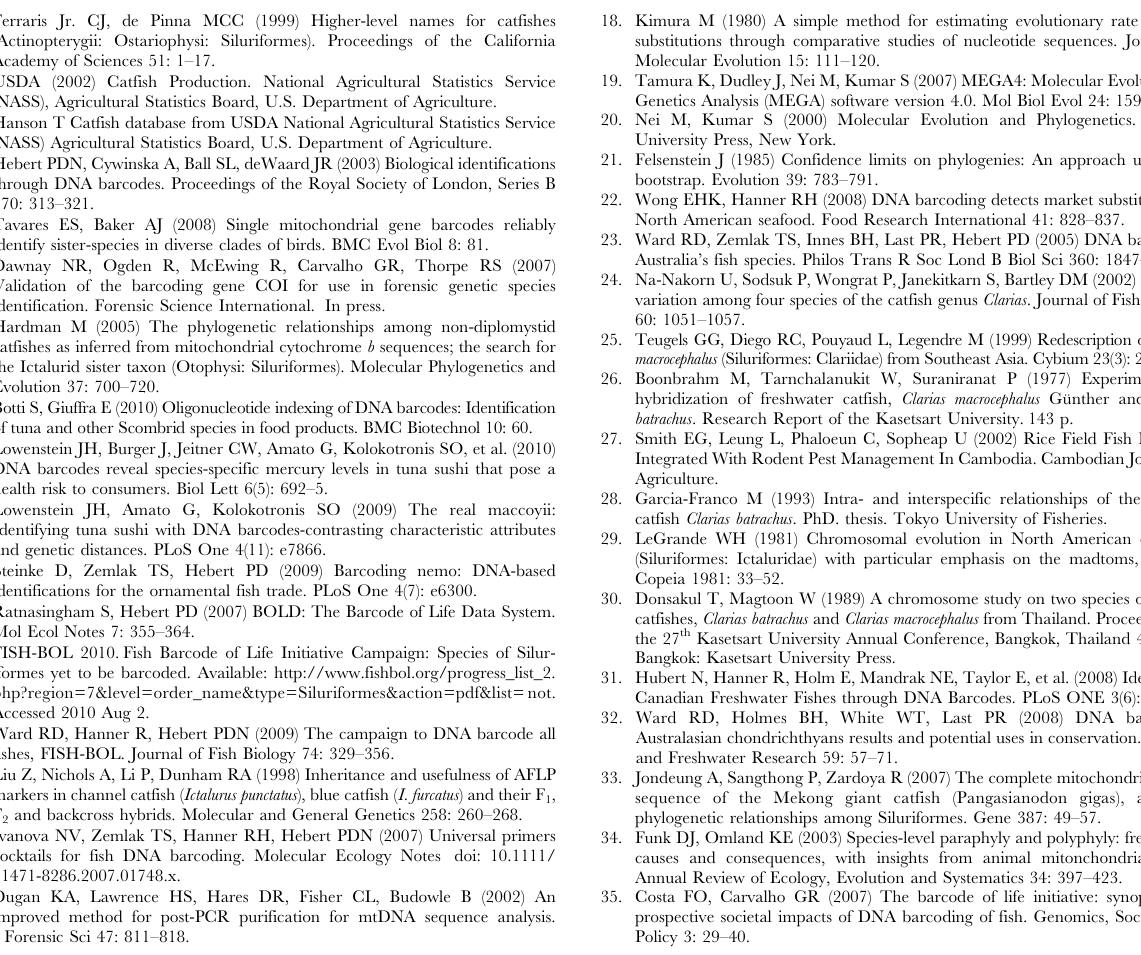
Table S1 Primers used for PCR amplification and sequencing.